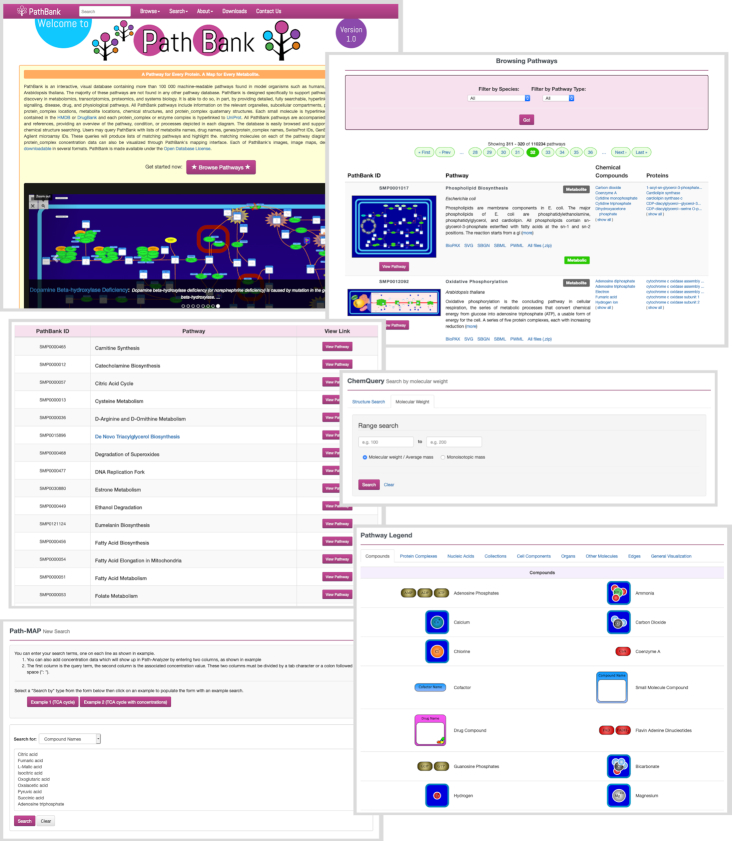
A screenshot montage of different browsing and searching screens taken from PathBank. A more detailed description of the different functions and capabilities of the various browse and search tools in PathBank is given in the text.